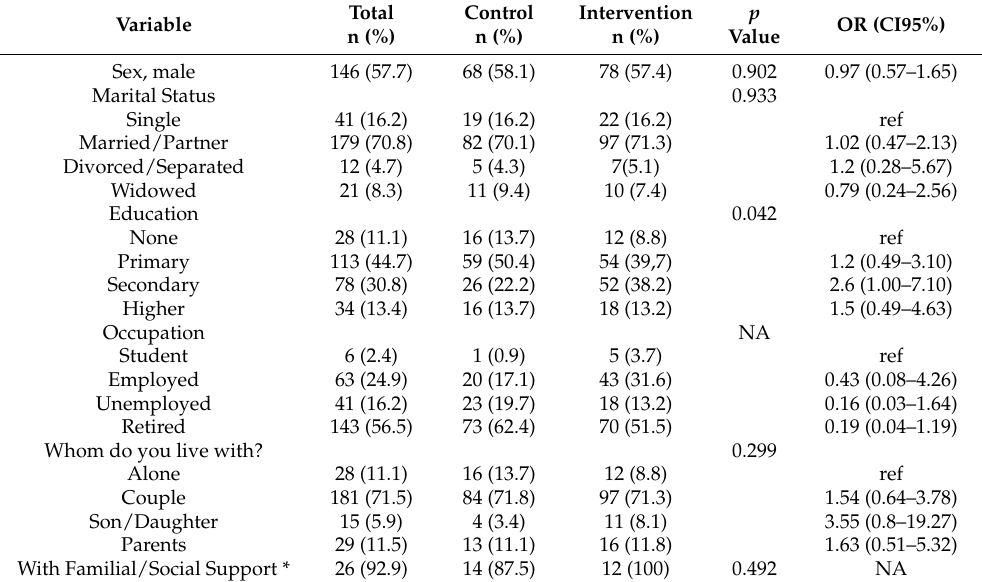
Table 1. Sociodemographic